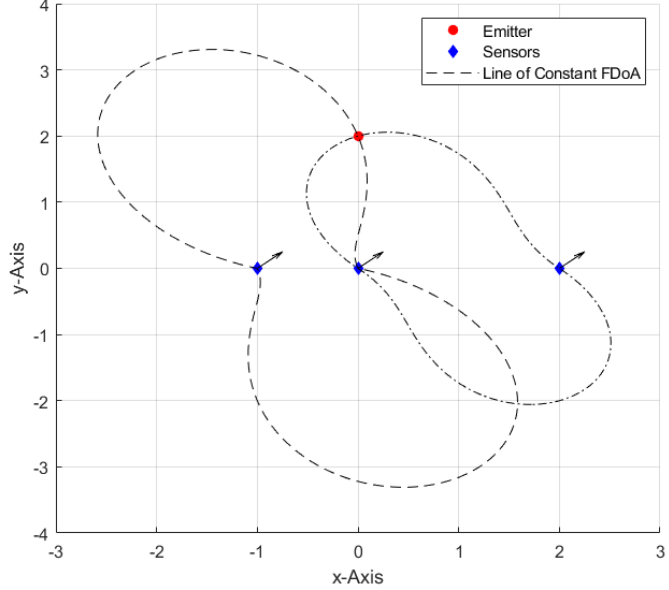
Figure 1. Lines of constant frequency difference of arrival (FDoA) with a stationary emitter and three sensors moving toward the indicated direction.